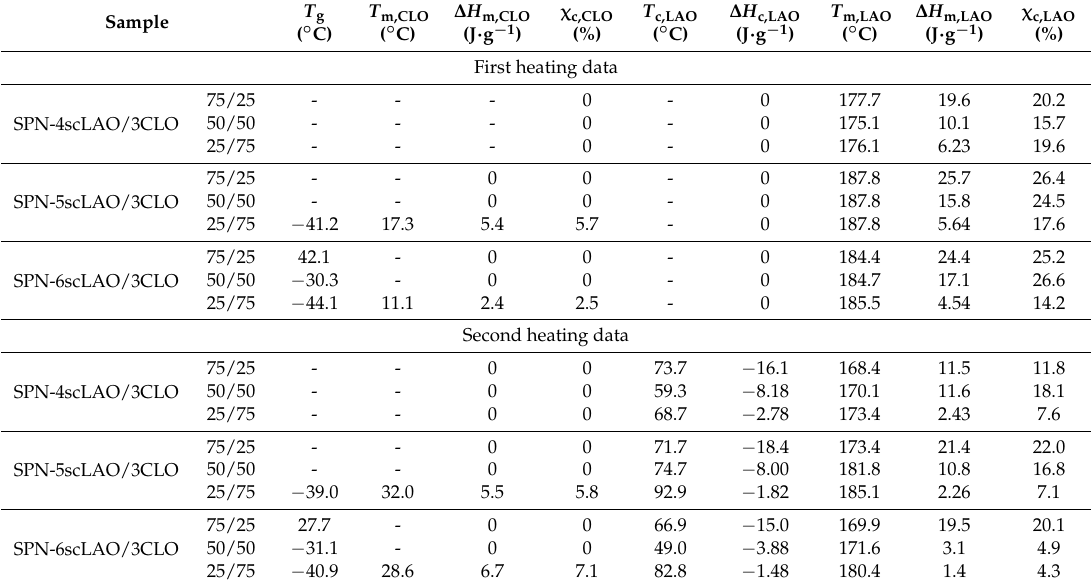
Table 3. DSC data for SPN- m scLAO/CLOs ( m = 4, 5 and